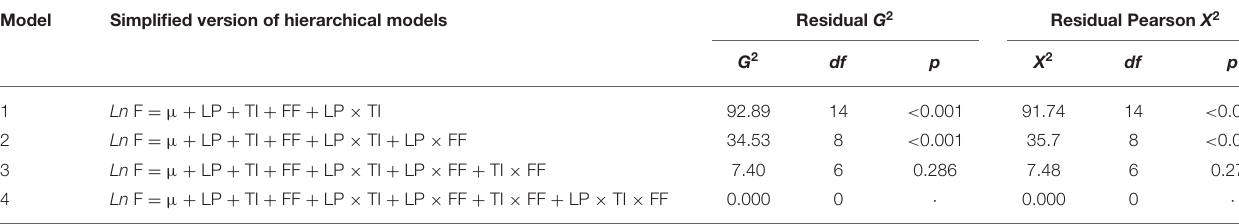
TABLE 7 | Logit model analysis of proportional focus of feedback by lesson purpose and type of interaction. Model Simplified version of hierarchical